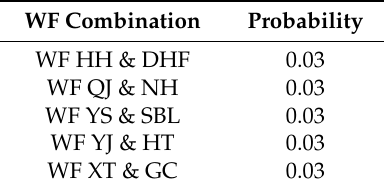
Table 3. The considered disturbance scenario and its probability.